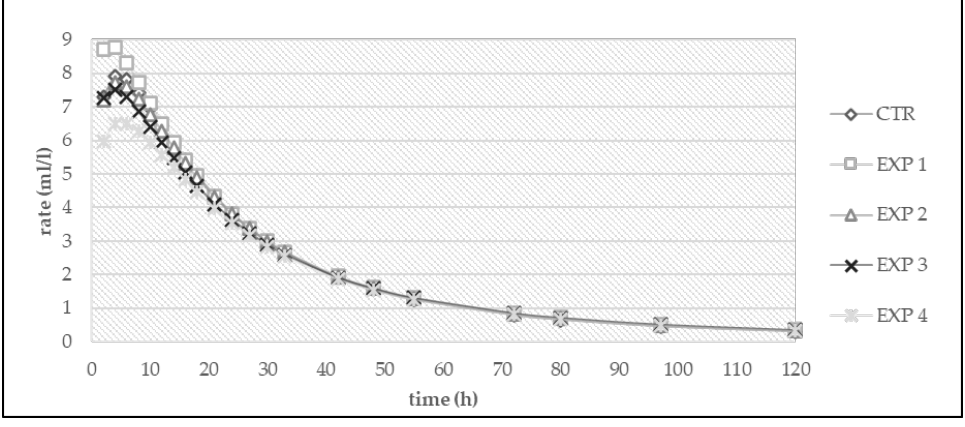
Figure 4. In vitro fermentation rate over time in control and experimental diets with bovine inoculum. In Table 5, the least square means for the in vitro fermentation results at 120 h of incubation, considering the five substrates incubated with both inocula , are reported. Either inoculum or substrate, and their interaction, significantly ( p < 0.01) affect all the fermentation